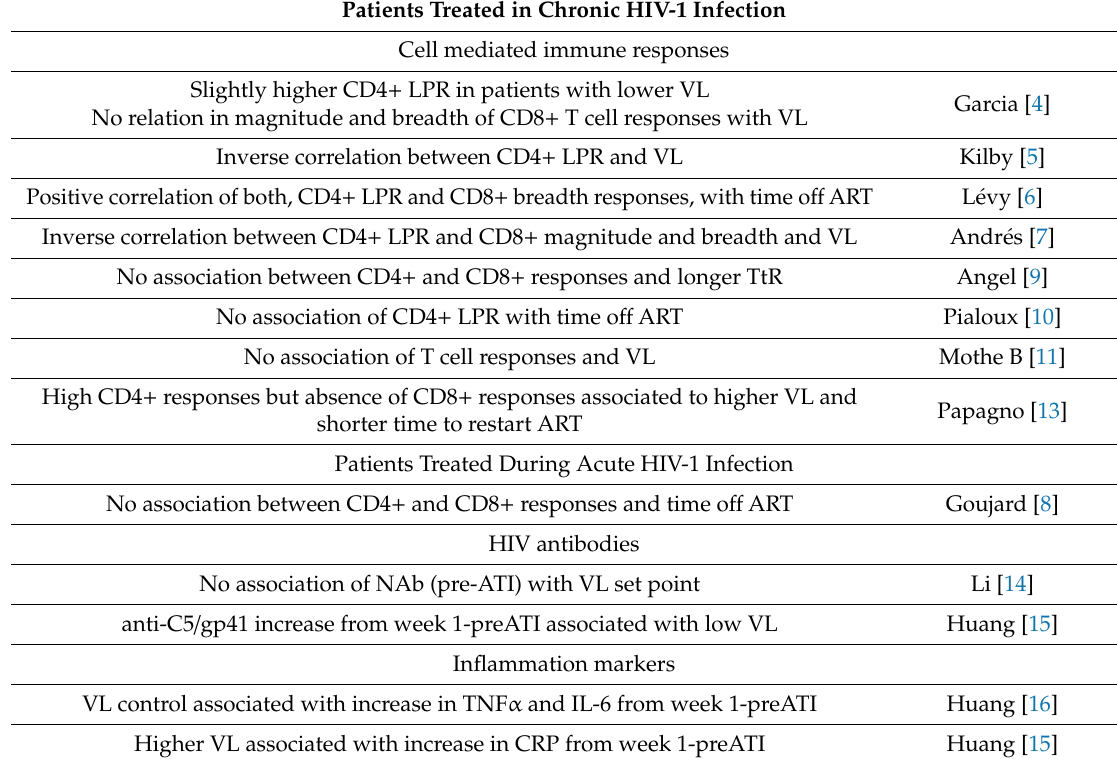
Table 3. Immunological responses and